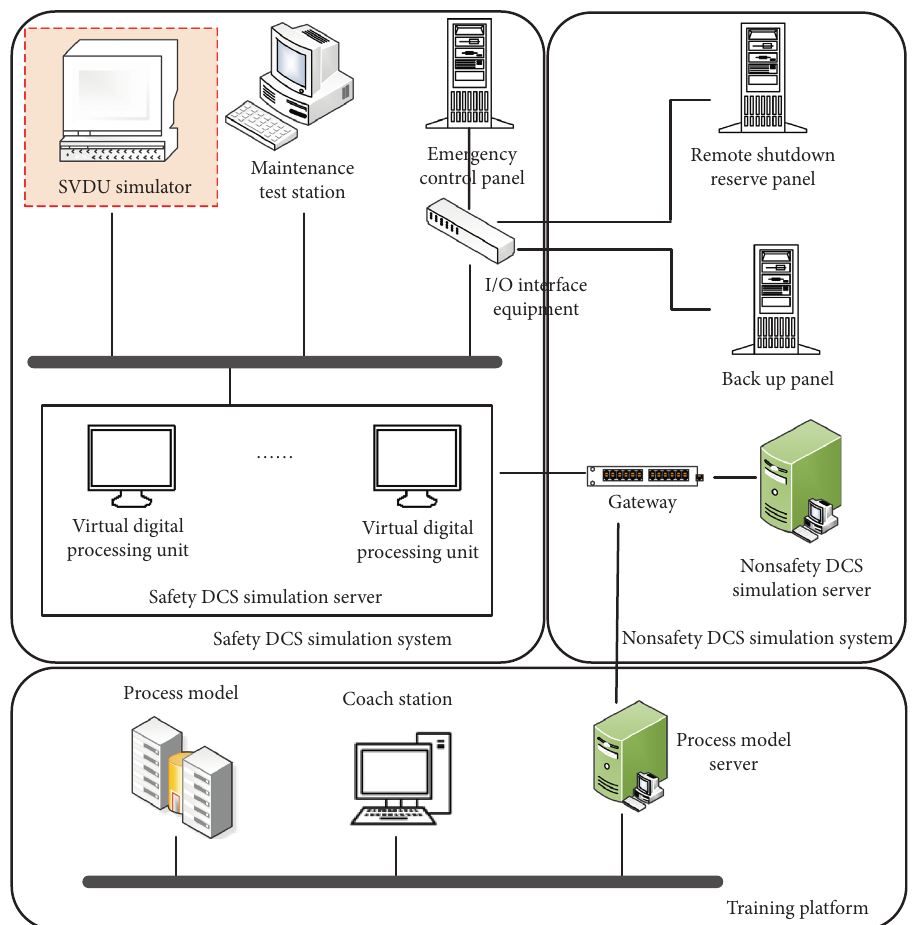
Figure 3: Interface relationship between SVDU simulator and other parts in full scope simulator.